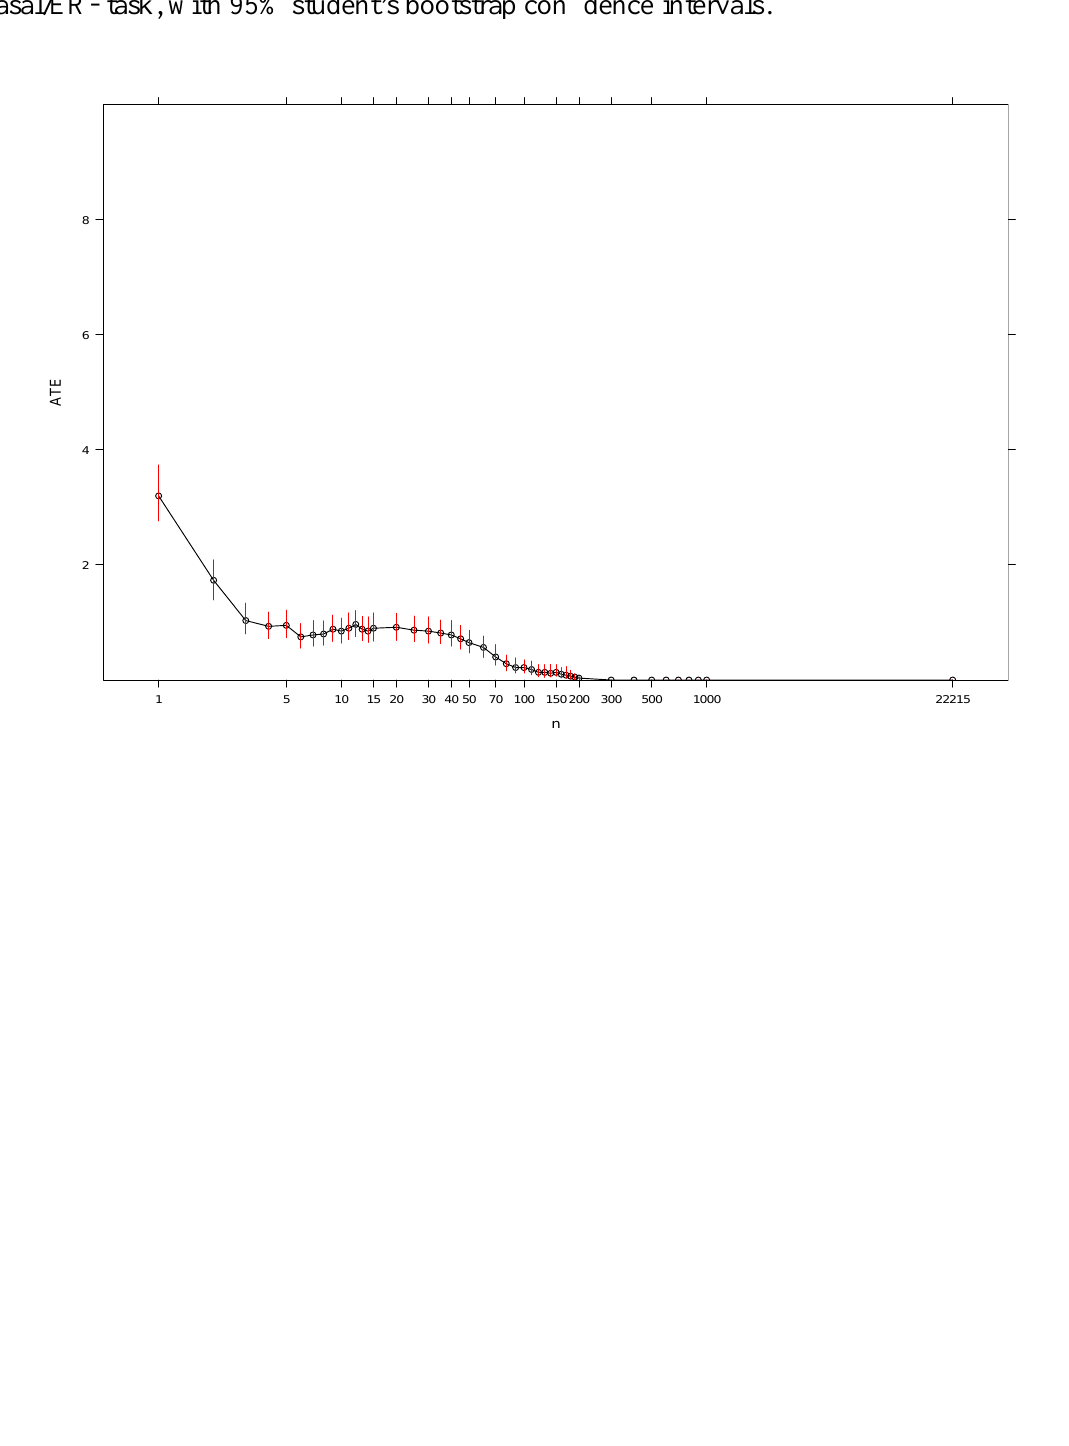
The Average Test Error is displayed for gene expression data and the Lum/ER+ vs. Basal/ER- task, with 95% student’s bootstrap confidence